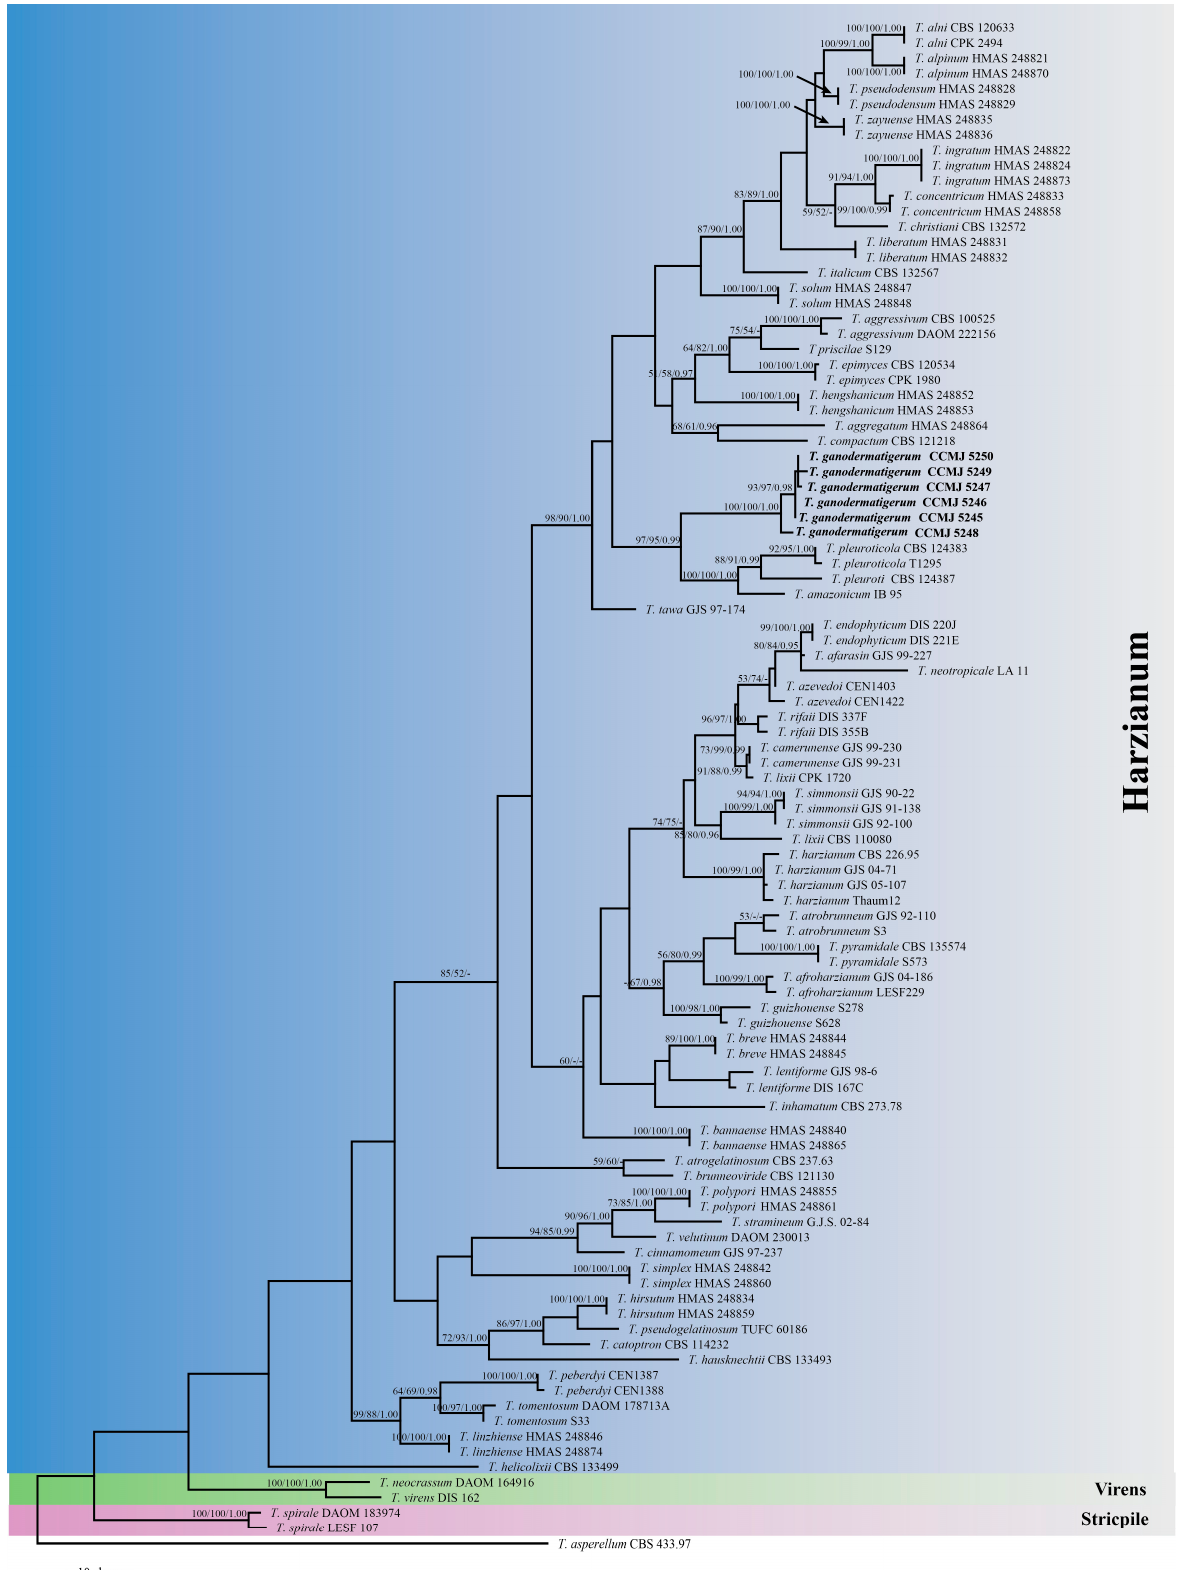
Figure 1. Phylogeny of Trichoderma using MP analysis based on combined TEF1 and RPB2 sequences. MPBP ≥ 50%, MLBP ≥ 50%, and BIPP ≥ 0.9 are shown on the branches (MPBP/MLBP/BIPP). The sequences in bold are the new species.